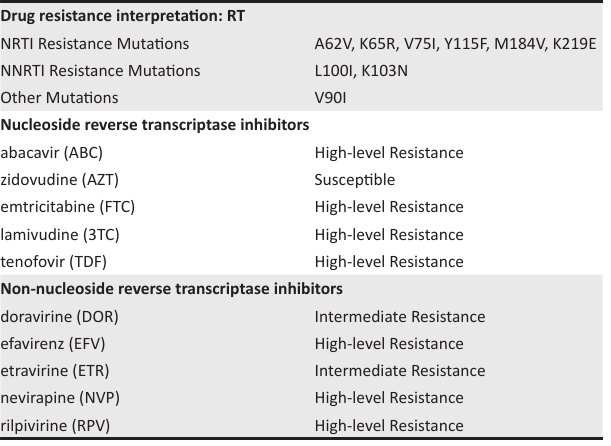
TABLE 1: Drug resistance report at 12 months. Drug resistance interpretation: RT NRTI Resistance Mutations